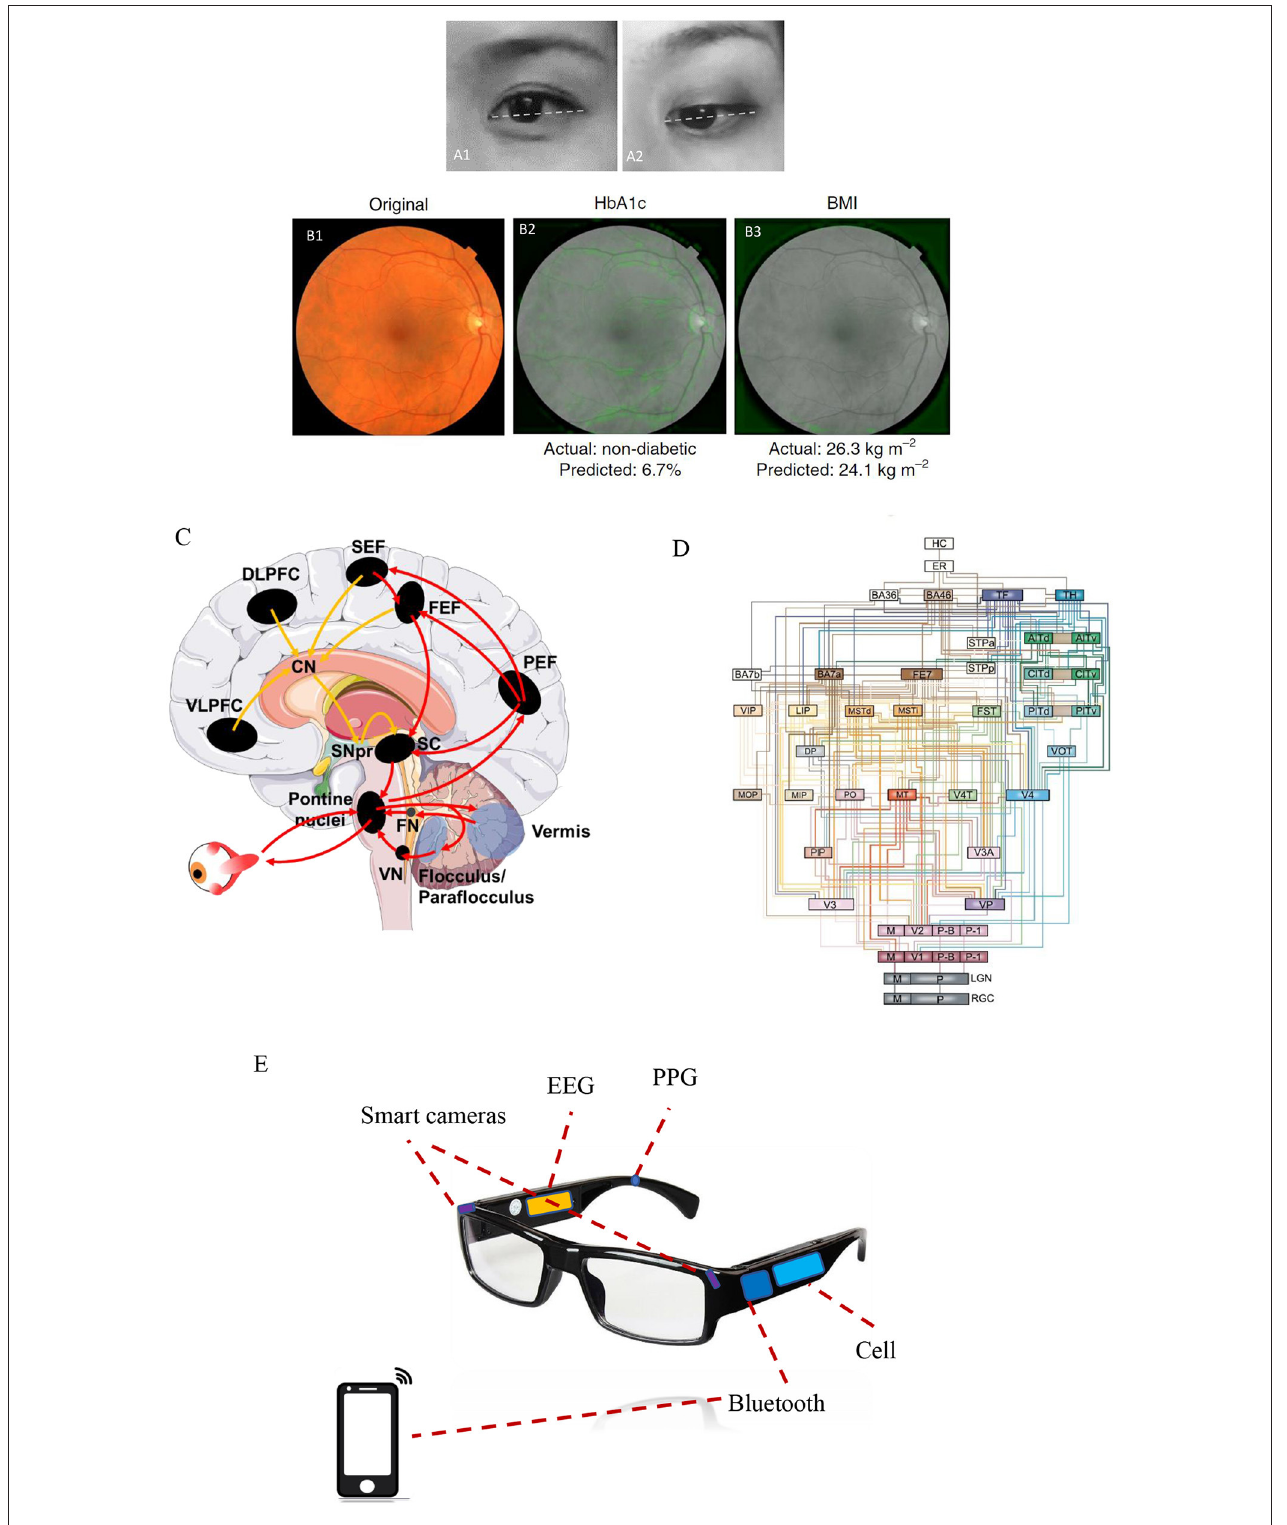
FIGURE 1 | The eye as a window to uncover a healthy level of the brain. (A1) A restful and calm eye (positive state) is shown compared with (A2) a stressful and anxious eye (negative state). Note that a positive state is more frequently associated with an upside view of the eyes, whereas a negative state exhibits a